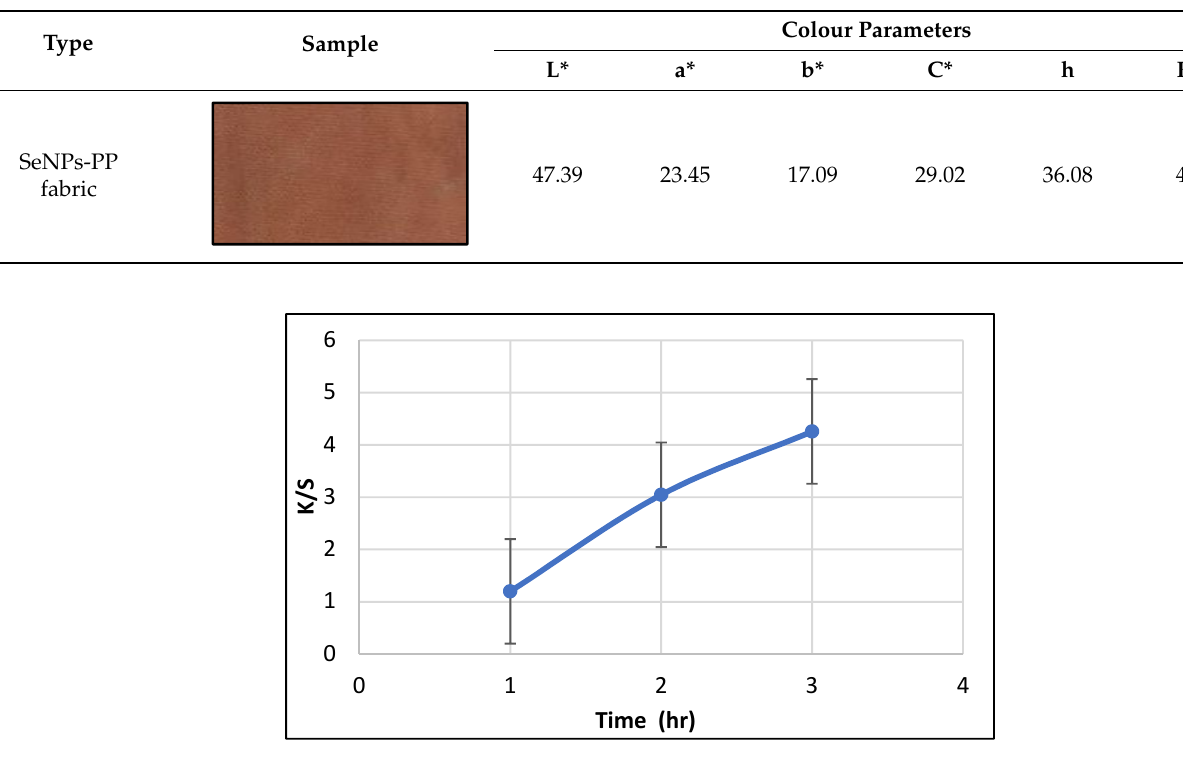
Figure 7. Effect of treatment time on color strength (K/S).